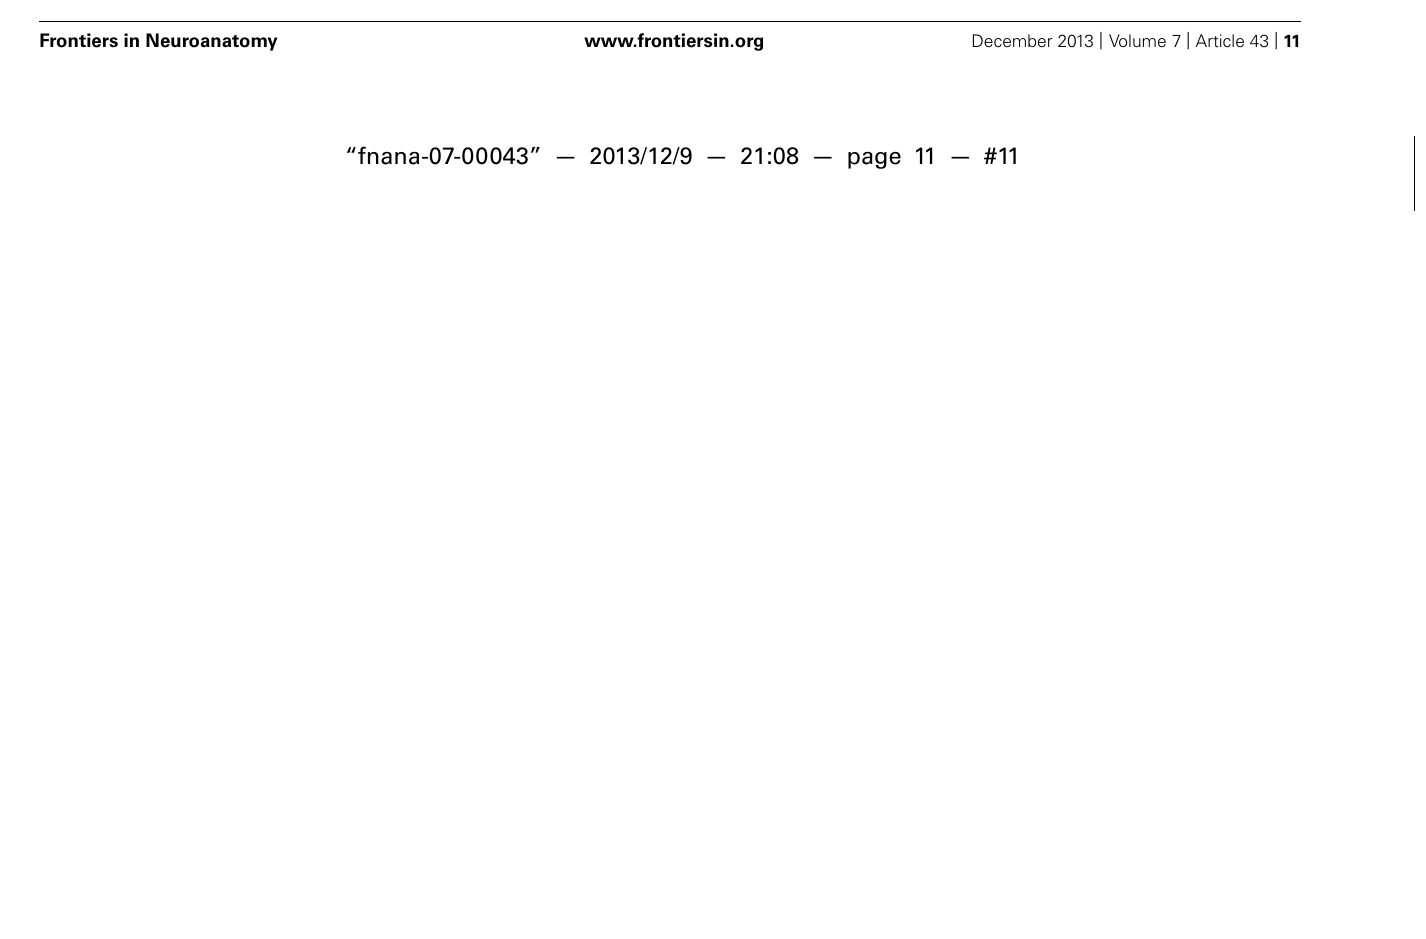
FIGURE 7 | Fluorescent images showing hrGFP-IR axons and termini from theAcbC (A–E; M-7) and ventralAcbSh (F–I; M-21) injections. (A–E) Axons with varicosities invade the ventral tuberomammillary nucleus [ (A) ,VTM], the ventral tegmental area [ (B) ,VTA], the medial raphe nucleus [ (C) , MnR], the dorsal raphe nucleus [ (D) , DR], and the ventrolateral periaqueductal gray [ (E) ,VLPAG] after injection with AAV-lox-hrGFP into the